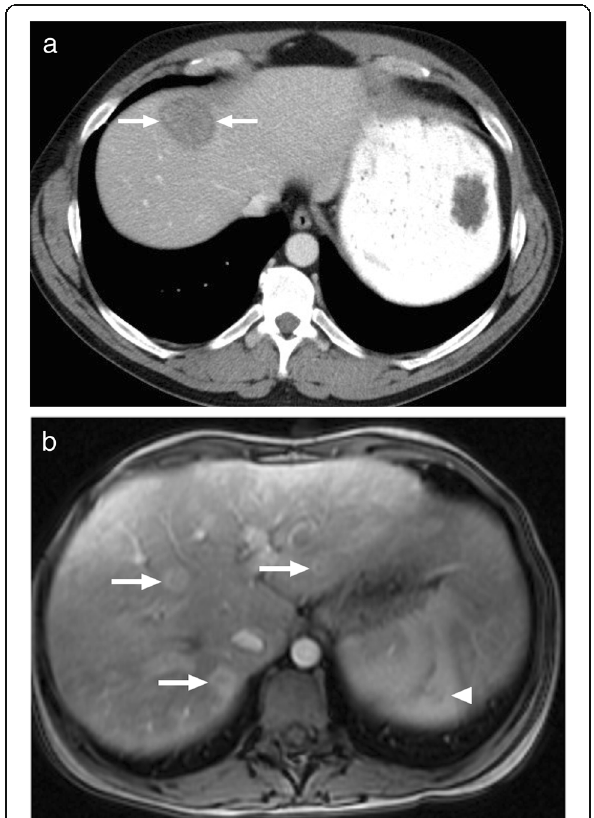
Fig. 14 Images of two different patients with pathologically proven hepatic Bartonella granulomas. a Axial plane postcontrast CT image of a 45-year-old male demonstrates predominantly hypodense solid mass (arrows), with central heterogeneity, located in the liver dome. Surgical resection of this lesion confirmed Bartonellosis. b A 13-year- old girl presented with abdominal pain and referred for MRI with liver lesions detected on ultrasound. Axial plane postcontrast arterial phase image demonstrates avidly ring-enhancing liver masses (arrows) and similar lesions in the spleen (arrowhead) which were more evident on portal venous phase image (not shown). These lesions were concerning for hypervascular metastasis. Acute titers were positive for Bartonella and the patient recovered